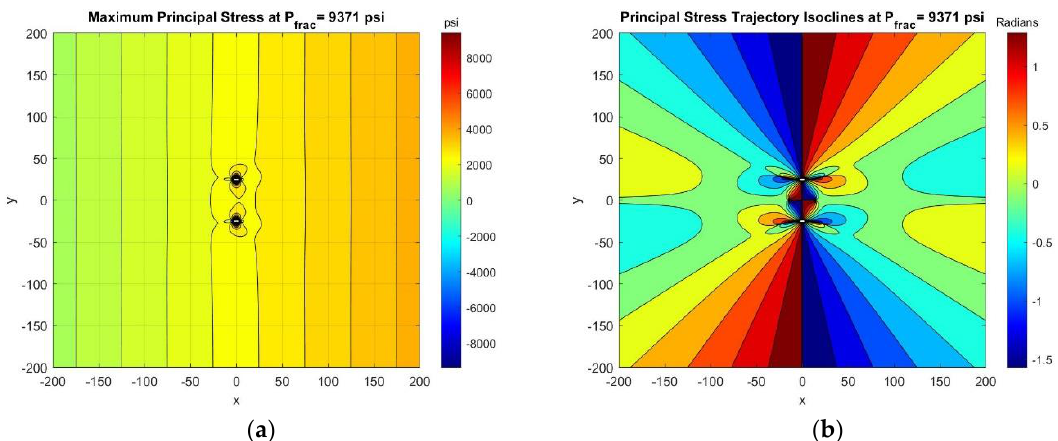
Figure 11. TLSM model results for the initial hydraulic fracture nuclei showing ( a ) maximum principal stress. Color code is shifted with respect to Figure 10a, due to stress peaks at the fracture nuclei. ( b ) Principal stress trajectory isoclines at t = 0.093 min. TLSM results were generated in 0.466 s including post-processing.